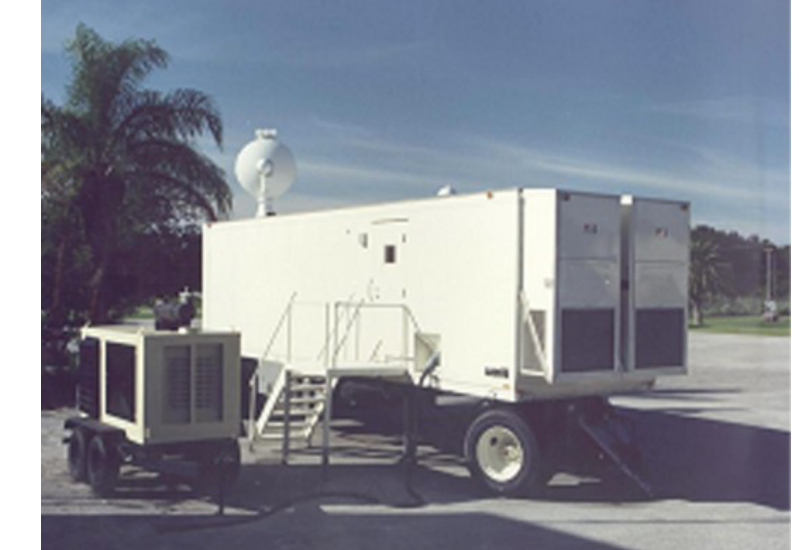
Figure 13 – Telemetry System PCM/FM, US company LORAL - ground receiver mobile station (Arhiv Vazduhoplovnog opitnog centra, 2016) Рисунок 13 – телеметрическая система PCM / FM, американской компании